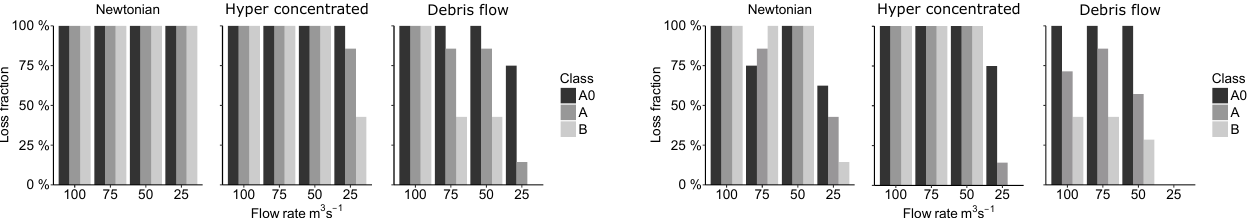
Figure 12. Building loss fraction for all flow scenarios where build- ings are assumed to have a brick width of 0.15m.